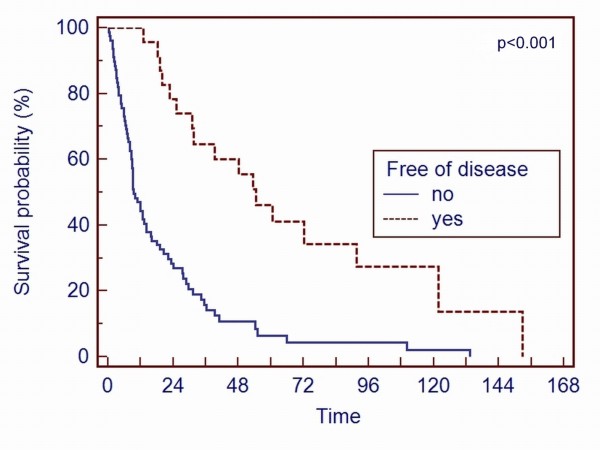
A Kaplan-Meier survival curve of patients stratified on the basis of being diagnosed as "free of disease" or not shows that patients with the diagnosis "free of disease" at any time after the operation had a better survival (p < 0.001).